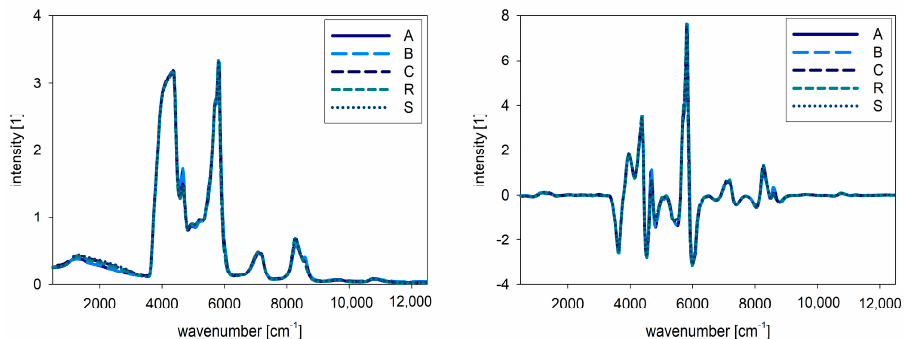
Figure 2. NIR spectra of native oils, A: chia, B: chia, R: rape seed, S: sunflower, C: corn, raw spectra ( left ), pre-processed spectra ( right ).